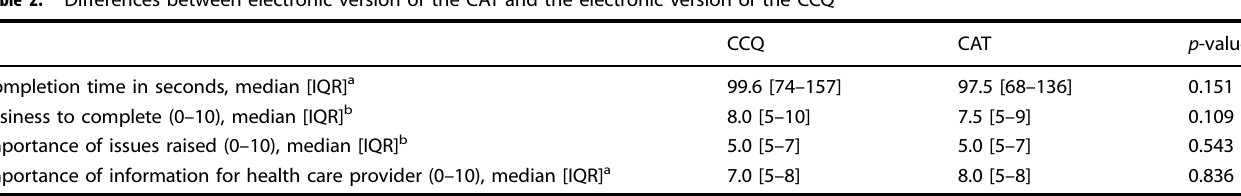
Table 2. Differences between electronic version of the CAT and the electronic version of the CCQ